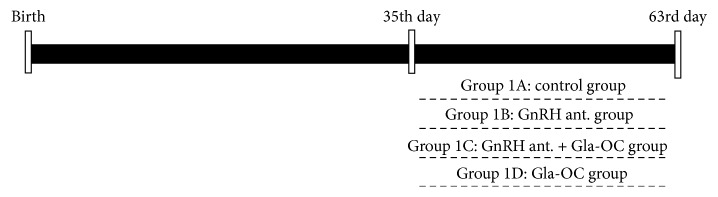
Group 1: postnatal normal adult Leydig cell development surgical procedure.